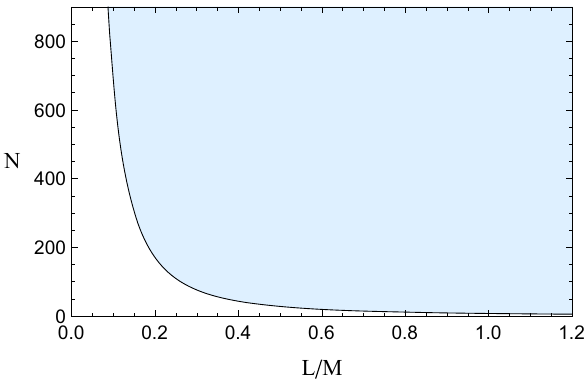
Fig. 3 Plot showing the parametric region for the NEC to be satisfied in the region r ∈ [ r (cid:10) border-black , solid curve , corresponds to the case r (cid:10)